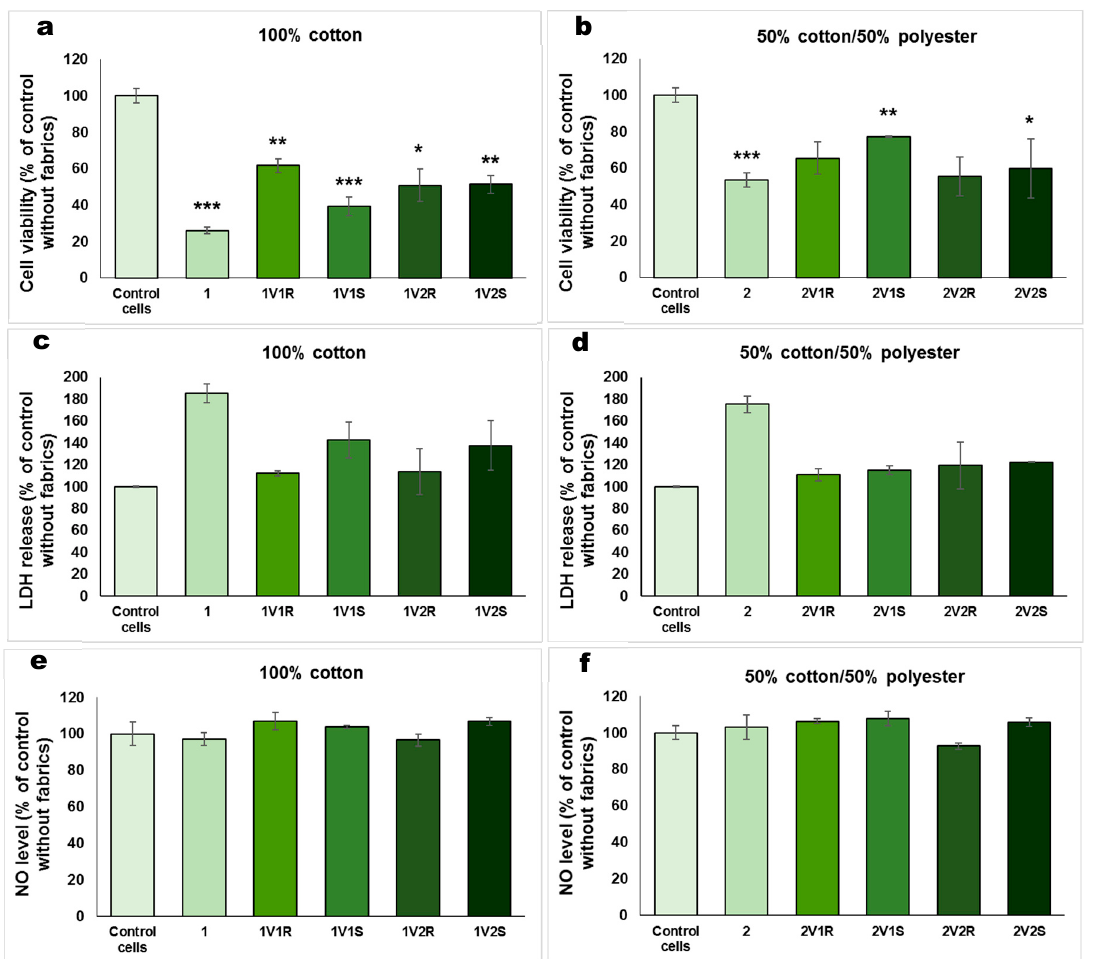
Figure 5. Biocompatibility in terms of cell viability ( a , b ), LDH release ( c , d ) and NO level ( e , f ) for 100% cotton and 50% cotton/50% polyester fabrics treated in different experimental variants with sage (S) and rose (R) microcapsules, that were incubated for 12 h with human dermal fibroblasts cultured without inserts. * p < 0.05, ** p < 0.01 and * p < 0.001 compared to the control.